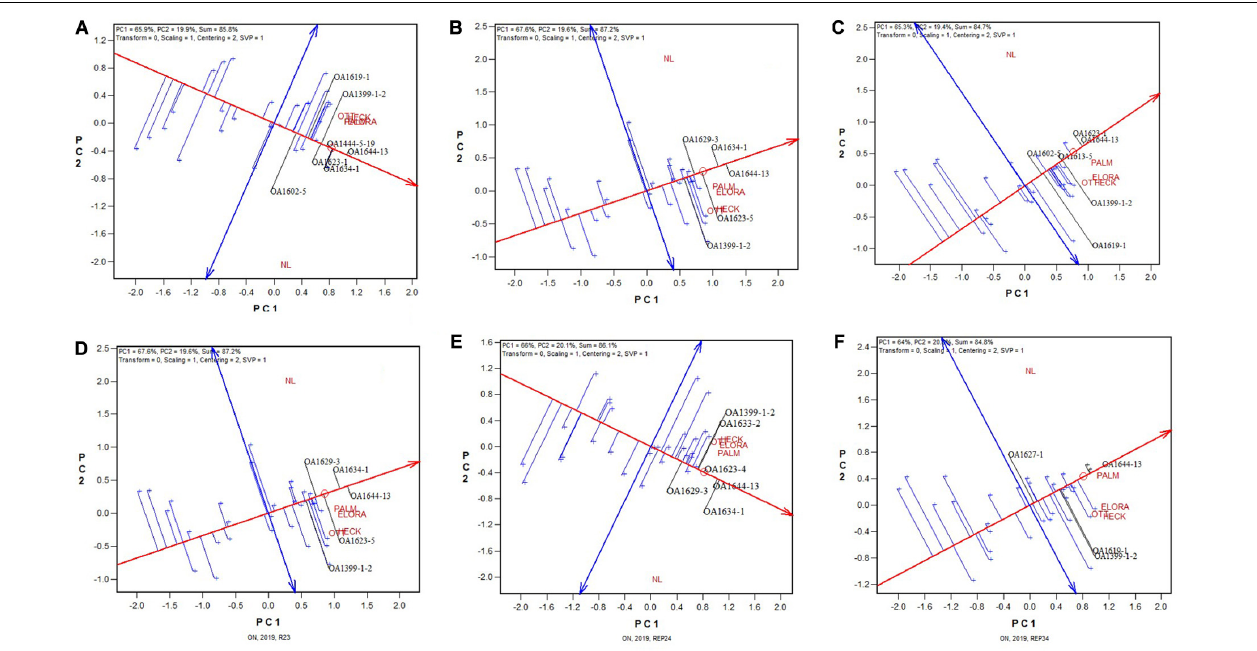
FIGURE 2 | GGE biplots based on the yield data from six 2-rep combinations for the 2019 Ontario trials; (A) combination of replications 1 and 2; (B) combination of replications 1 and 3; (C) combination of replications 1 and 4; (D ) combination of replications 2 and 3; (E) combination of replications 2 and 4; and (F) combination of replications 3 and 4. Note that these 2-rep combinations are random samples of all possible 2-rep combinations because replication 1 at one location was unrelated to replication 1 at other locations. See Table 1 for the full names of the test locations. Some genotypes are spelled out in black color while most of them are represented by “+” for